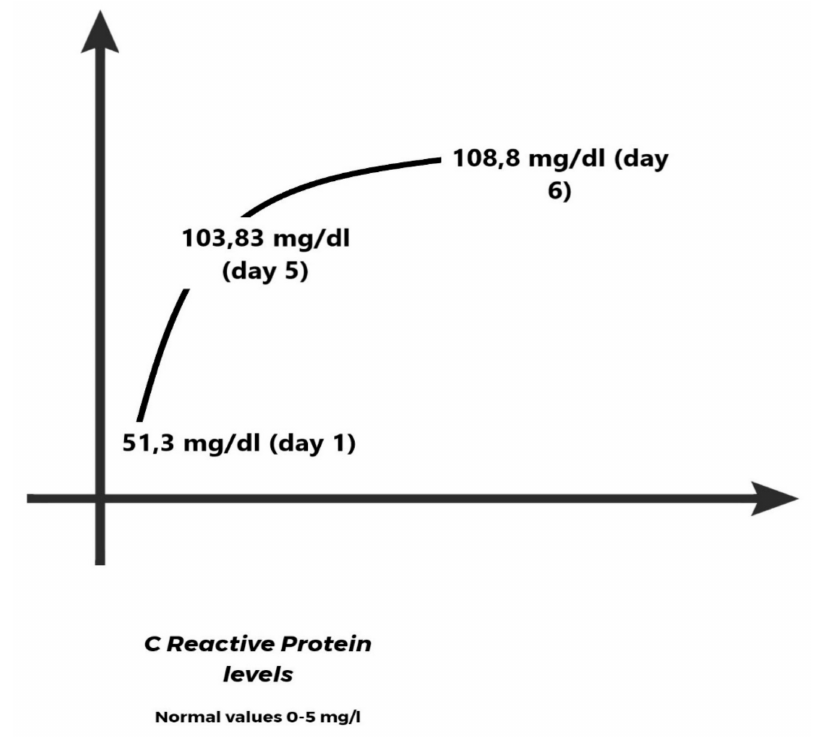
Figure 5. Changes in the C-reactive protein